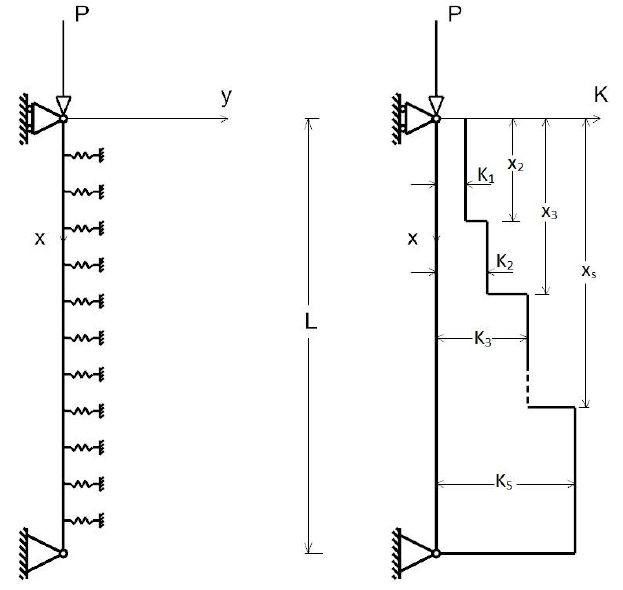
Figure 2. Model of the pile driven into multi-layered soil with s layers of different stiffnesses K. Function K(x) is assumed to be a step function. Therefore, depending on step height and spacing, K(x) can vary almost linearly with K h (x) (depending on soil type) or be constant.